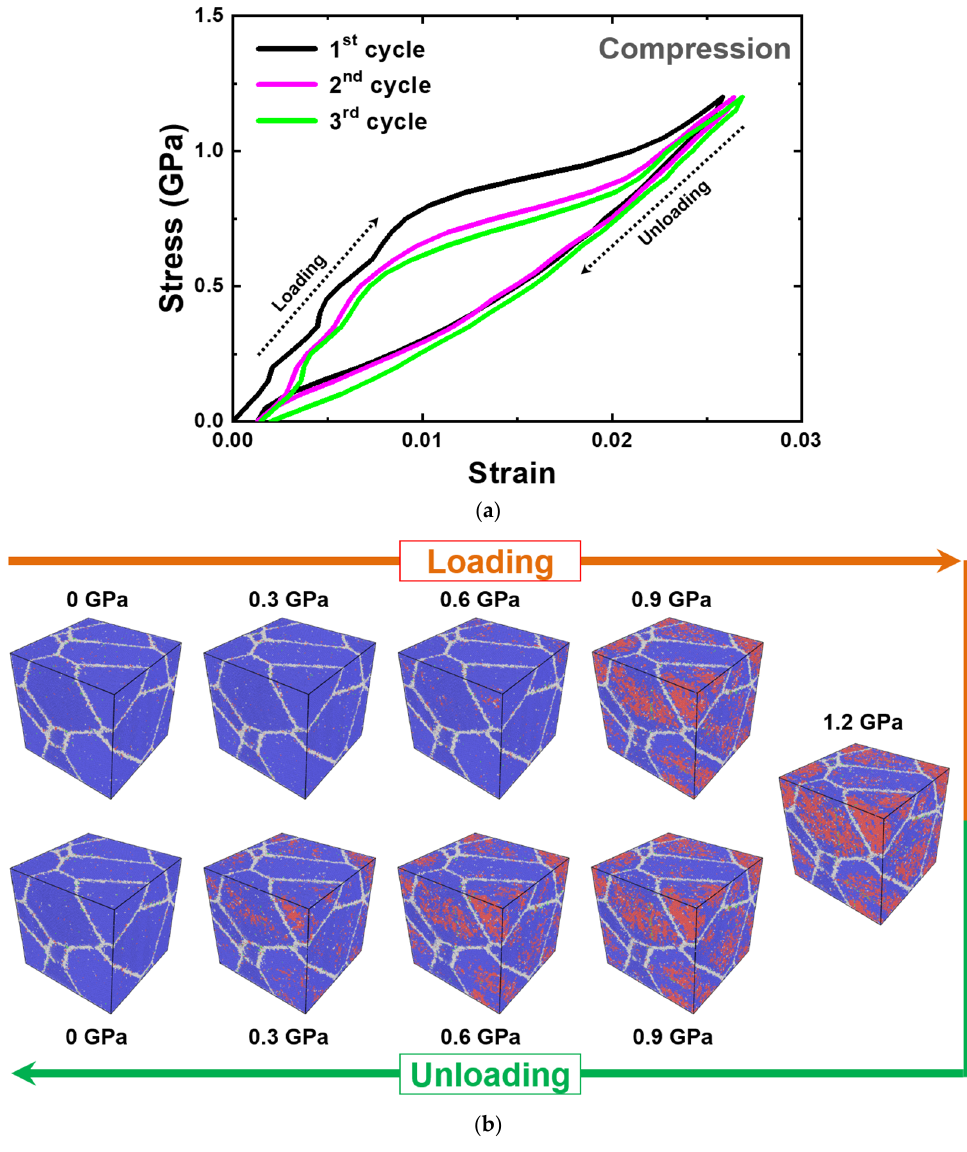
Figure 11. ( a ) Compressive stress–strain curve of the nanocrystalline equiatomic PtTi with five grains simulated at 1300 K. ( b ) The corresponding atomic configurations of the third cycle colored according to the PTM method [95] at regular intervals. The blue atoms correspond to the B2 austenite structure, red atoms to the B19 martensite structure, green atoms to the twin boundaries, and gray atoms to the domain or grain